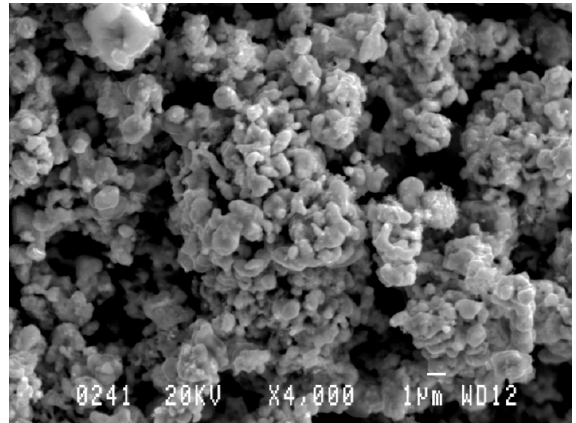
Figure 16. SEM images of a reduced ‐ carburized 0.27 Ni/(Ni + W) molar ratio sample at 1273 K.